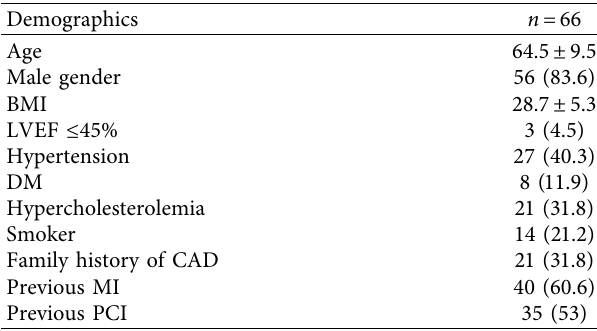
Table 1: Baseline demographic details: data represent n (% of total) for categorical variables and mean ± SD for continuous